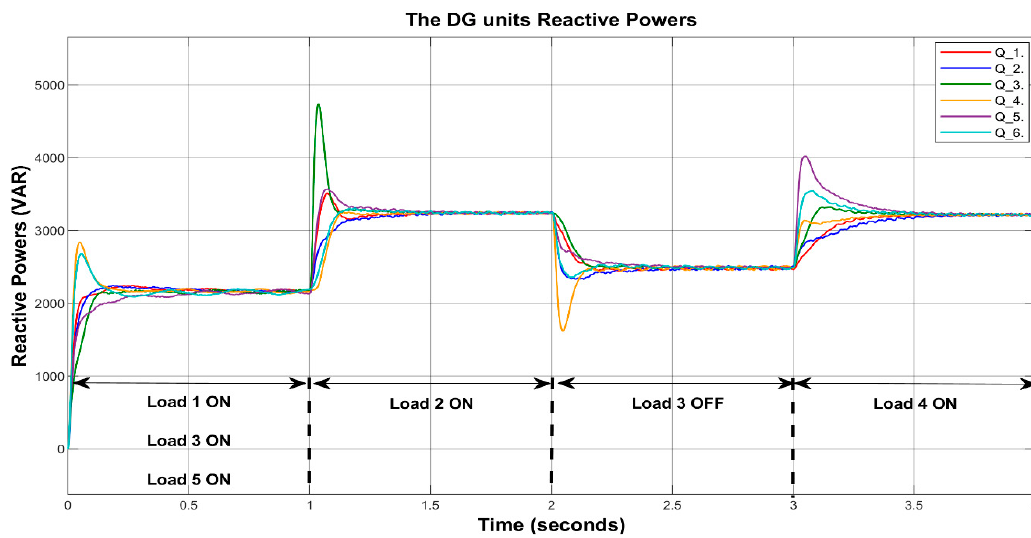
Figure 20. The DG units’ reactive powers for Case 5.